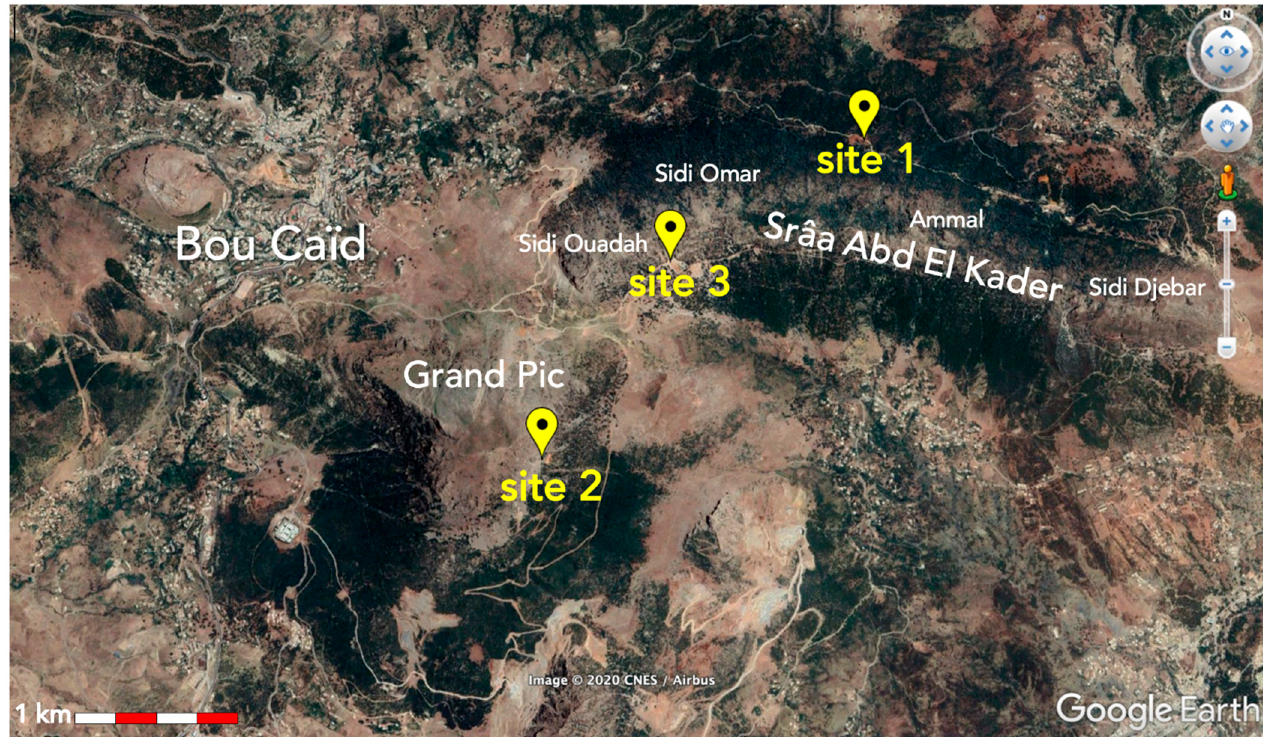
Figure 4. The three sampling sites; their GPS coordinates (latitude, longitude, and elevation) are site 1: 35°53 ′ 36.30”N, 1°39 ′ 34.52”E, 1500 m; site 2: 35°52 ′ 26.85”N, 1°38 ′ 09.45”E, 1710 m; site 3: 35°53 ′ 09.31”N, 1°38 ′ 42.57”E, 1567 m.